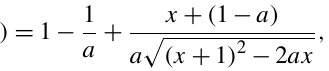
Figure 1. The degree of saturation climate versus climate aridity index ((cid:56))